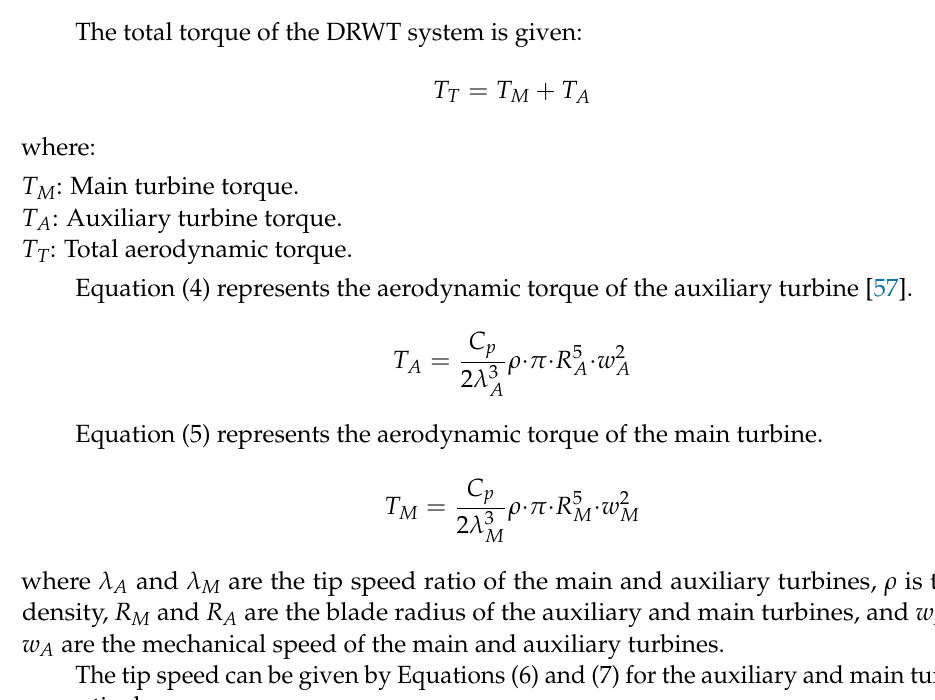
Figure 7. Block diagram of DRWP with a DFIG.